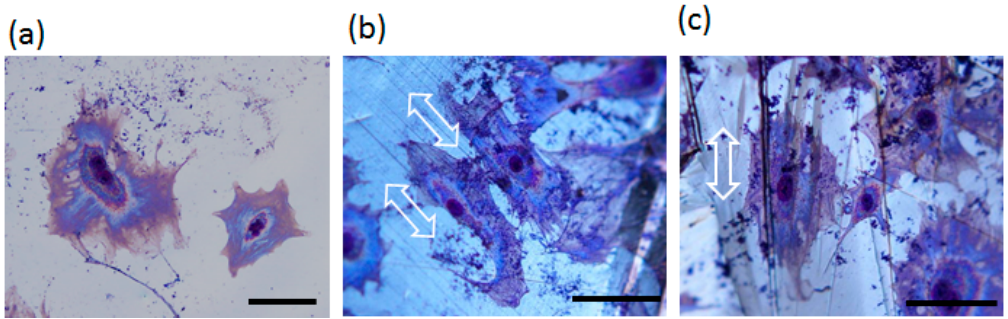
Figure 2. Giemsa staining of the osteoblasts on ( a ) a smooth surface and ( b , c ) deformed surfaces. Arrows indicate the direction of twinning and/or slip traces. Scale bar: 100 μ m.